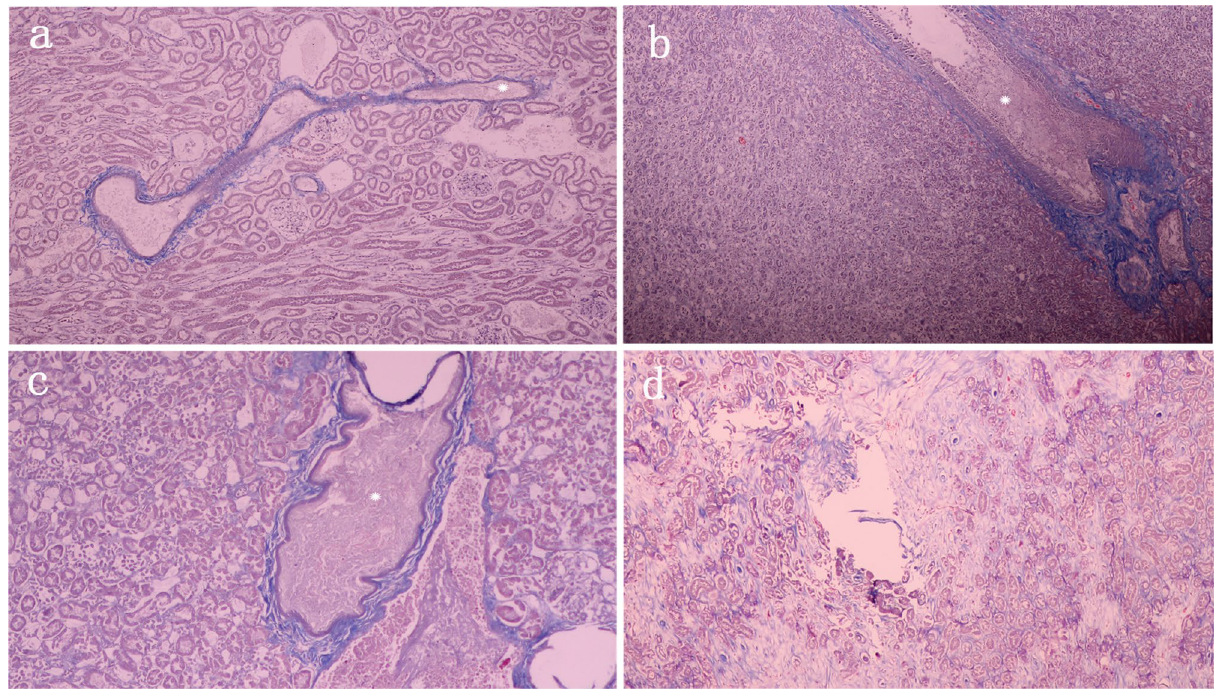
Figure 6. Representative images of Masson’s trichrome of the kidney at various times after embolization. ( a ) One week after embolization: a few inflammatory cells around the vascular cavity and the solid gel are